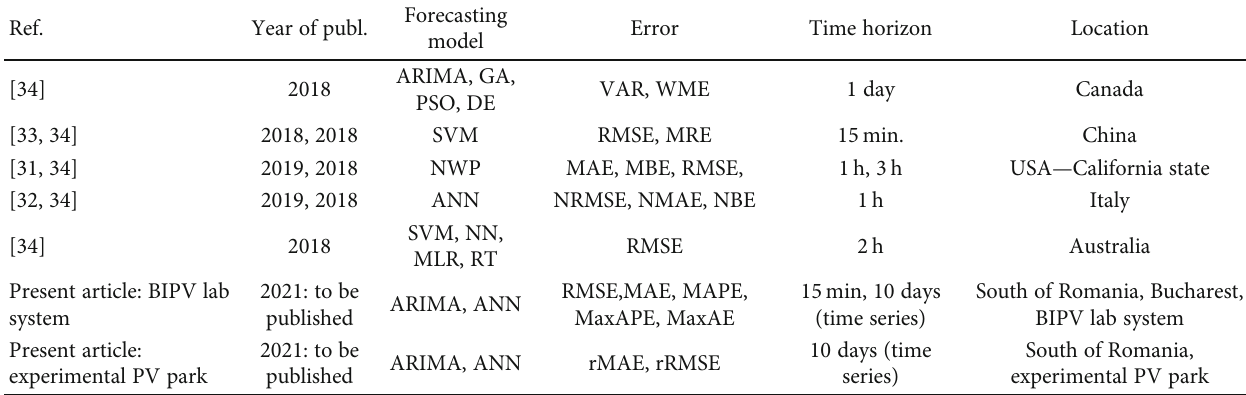
Table 10: Comparison of di ff erent forecasting models.